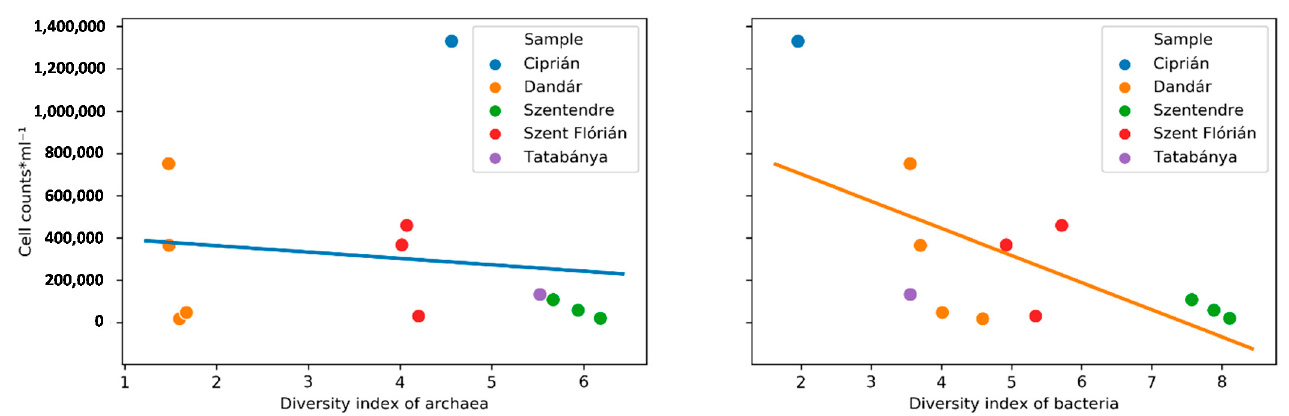
Figure 6. Relationship between the cell counts and Shannon diversity indices of the samples.